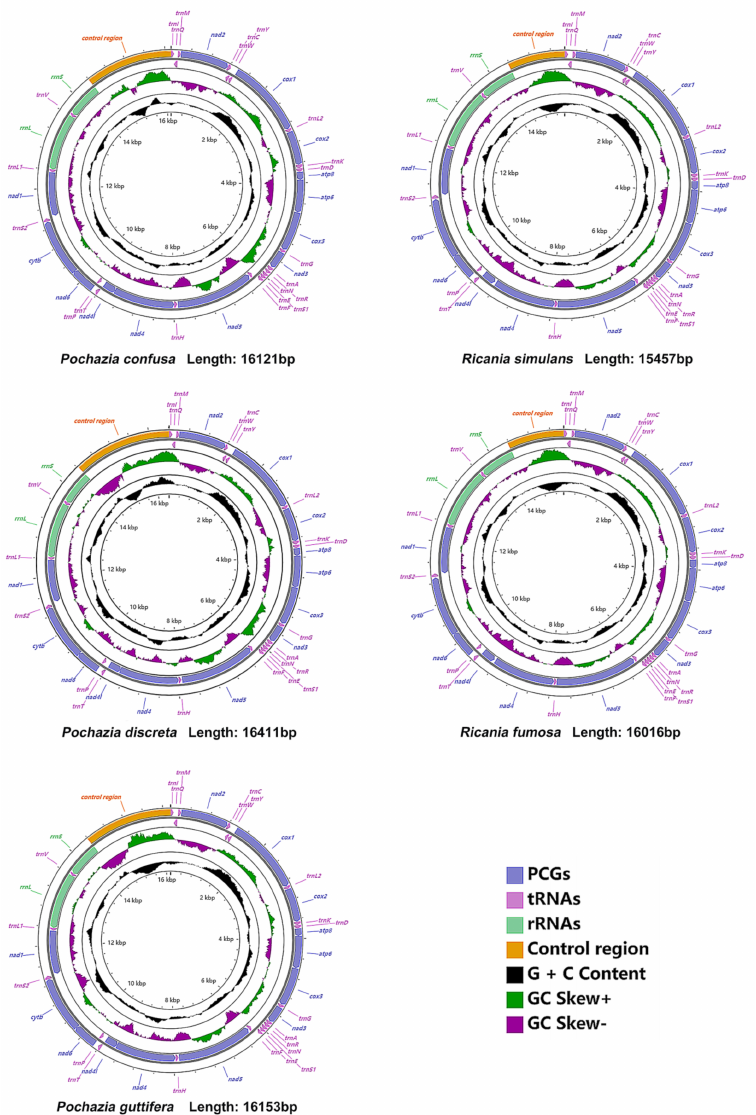
Figure 2. The mitochondrial genome of Pochazia confusa, Pochazia discreta, Pochazia guttifera, Ricania simulans and Ricania fumosa